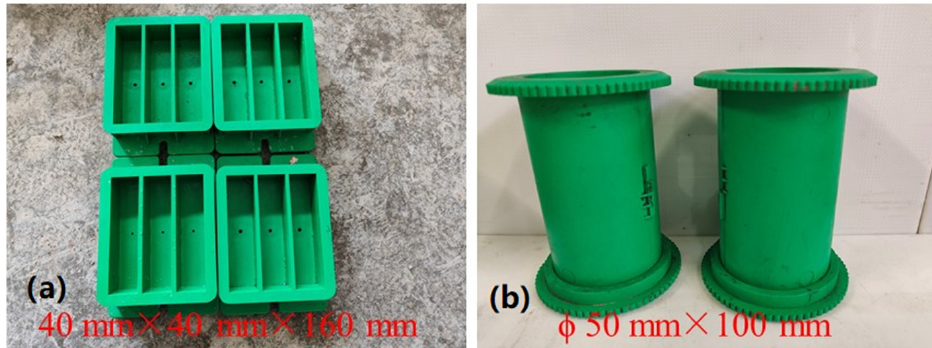
Figure 2. The test molds. ( a ) Prism stone mold ( b ) Cylinder stone mold.